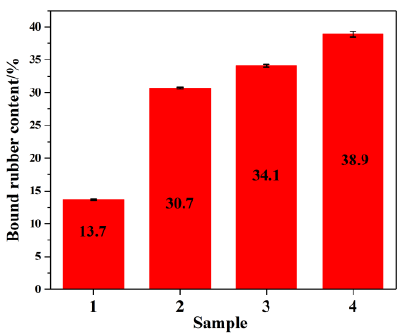
Figure 5. SEM image of the tensile fracture surface of the rubber composite: (1) SiO 2 /EUG/SBR; (2) MEST-SiO 2 /EUG/SBR; (3) SiO 2 /EEUG/EUG/SBR; (4) MTES-SiO 2 /EEUG/EUG/SBR.